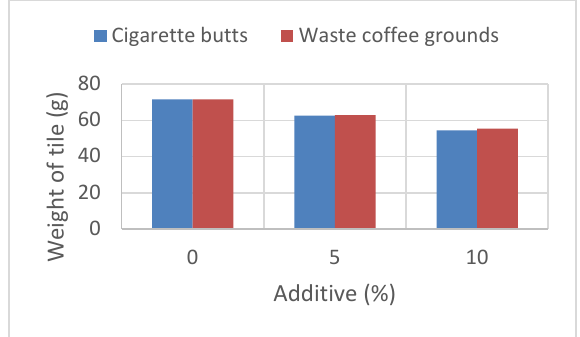
Figure 5. Weight changes of fired